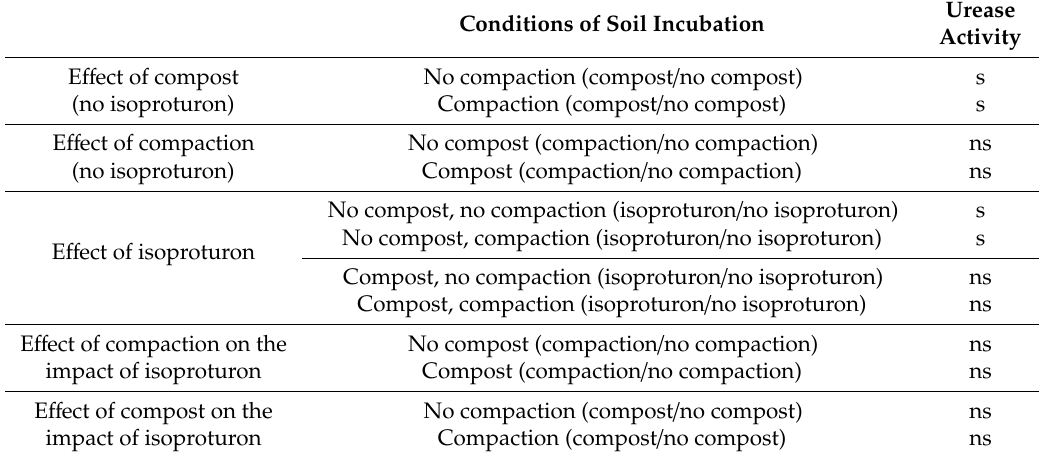
Table 3. E ff ect of compost amendment and compaction on the impact of isoproturon measured through the urease enzyme activity. s: significant e ff ect (Wilcoxon test, p < 0.05); ns: no significant e ff ect ( p >